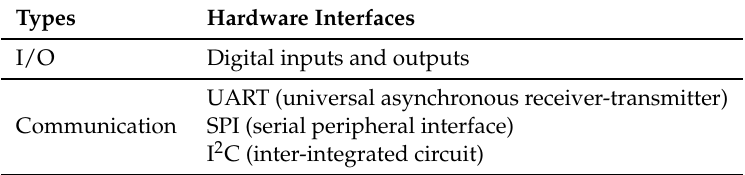
Table 2. Hardware interfaces for the oneM2M middleware